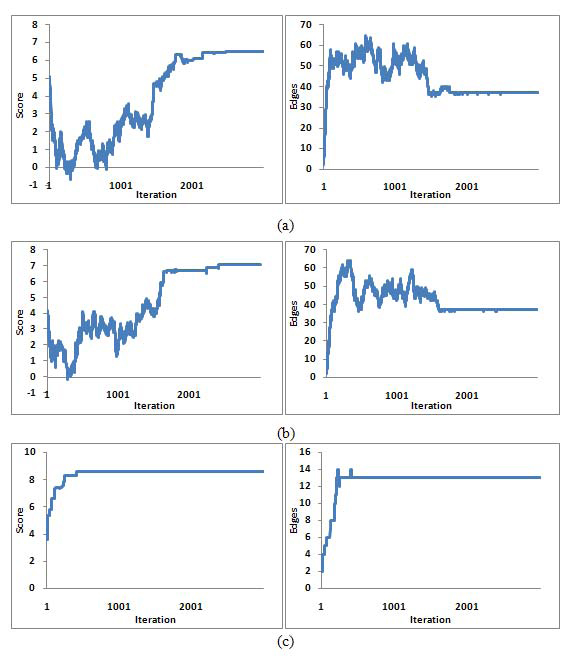
The variation of Score(L) and edges during annealing process in extensive searching. (a) Tstart=2, Tend=0.01, N=3000, (b) Tstart=1, Tend=0.01, N=3000, (c) Tstart=0.05, Tend=0.01, N=3000